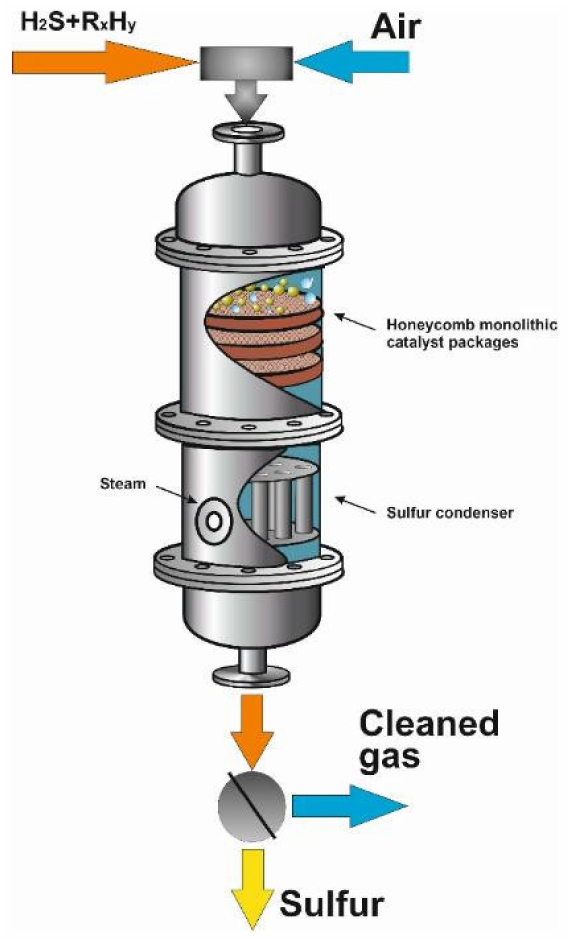
Figure 15. Direct catalytic H 2 S oxidation in a reactor via a monolithic catalyst with a honeycomb structure.